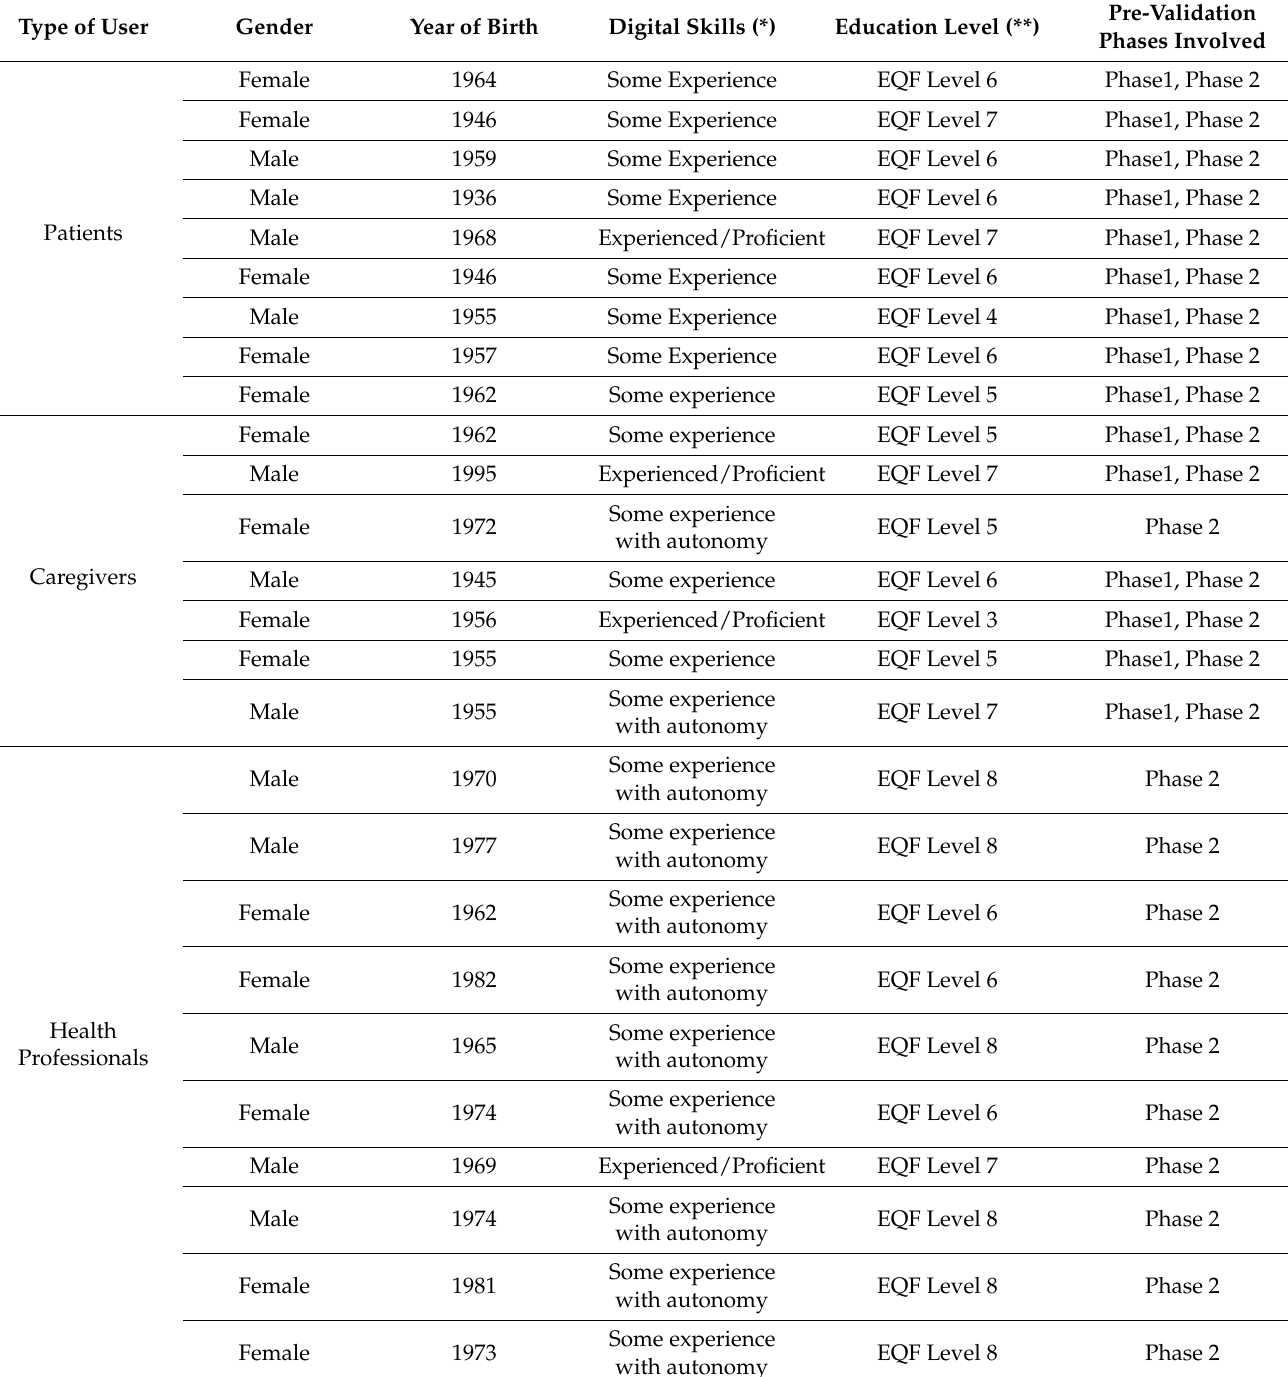
Table 9 shows data from participants related to the following five variables: type of user, gender, year of birth, digital skills, and education level. Table 9. Socio-demographic information of the recruited